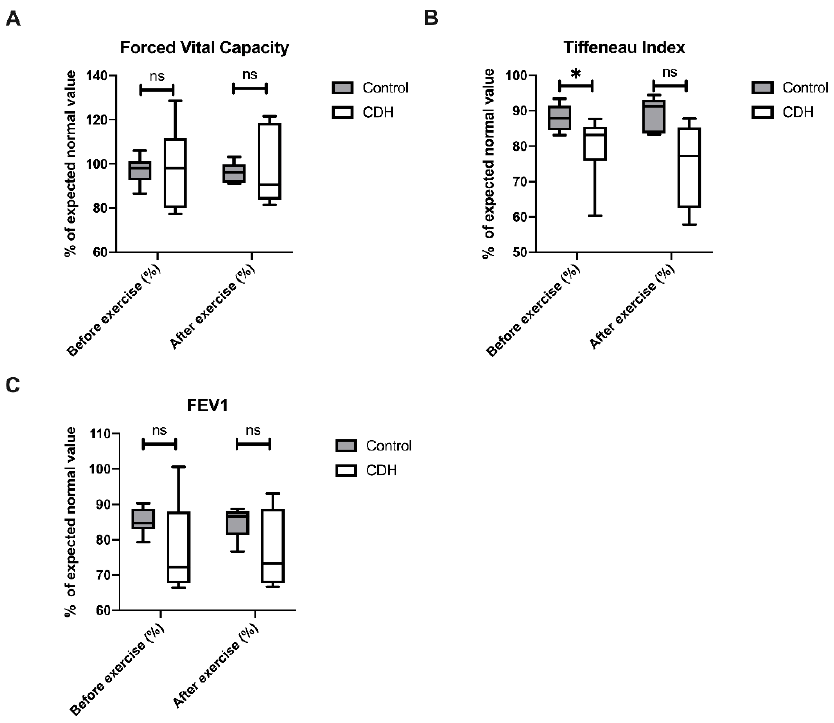
Figure 3. Forced vital capacity (FVC) ( A ), Tiffeneau Index ( B ) and forced expiratory volume in 1 second (FEV1) ( C ) before and after exercise of control patients and CDH patients; * p < 0.05. ns: not significant.